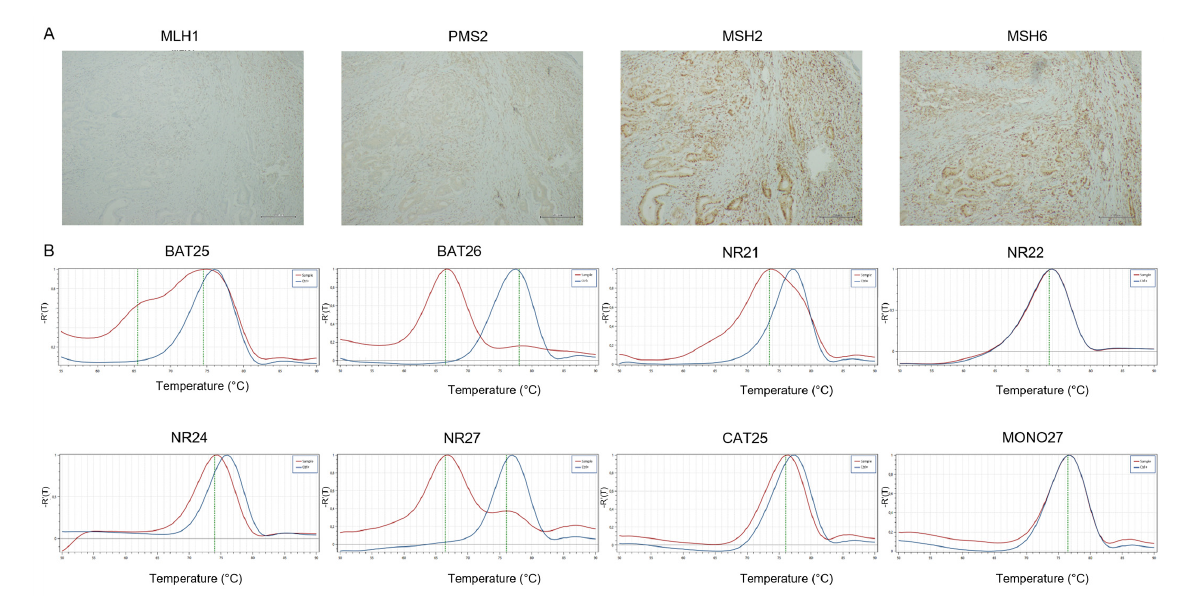
Figure 1. Representative results of CRC case showing dMMR-IHC and MSI-H by PCR. ( A ) MMR-IHC results: loss expression of MLH1 and PMS2 in tumor cells with positive internal control (original magnification 10 × ); intact expression of MSH2 and MSH6 in tumor cells (original magnification 10 × ). ( B ) MSI-PCR results: stability of NR22, NR24, CAT25 and MONO27; instability of BAT25, BAT26, NR21 and NR27 (red lines indicate samples while blue lines indicate MSS controls).